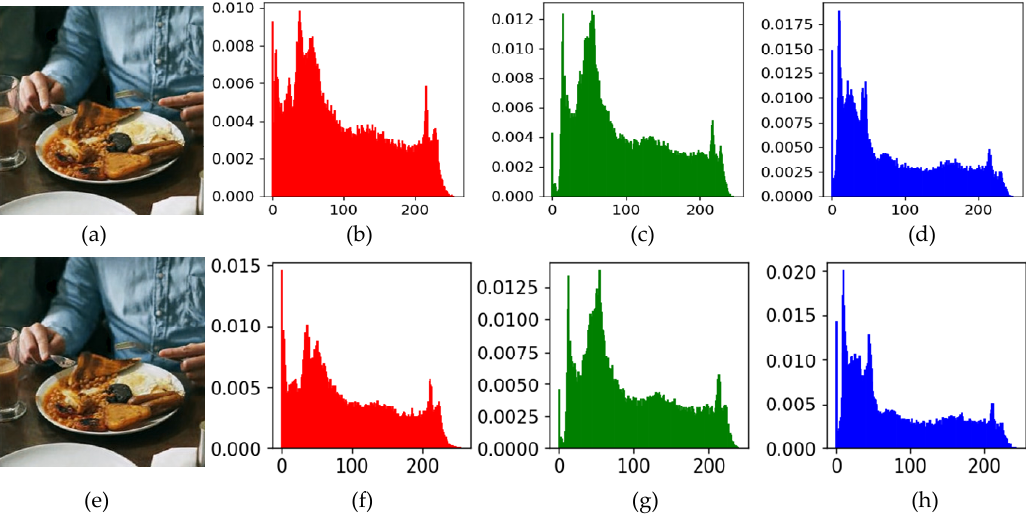
Figure 8. Histogram comparison between a secret image and a reconstructed secret image: ( a ) secret image; ( b – d ) histograms of pixel values of ( a ) for the three (RGB) channels, respectively; ( e ) reconstructed secret image; ( f – h ) histograms of pixel values of ( e ) for the three (RGB) channels, respectively.